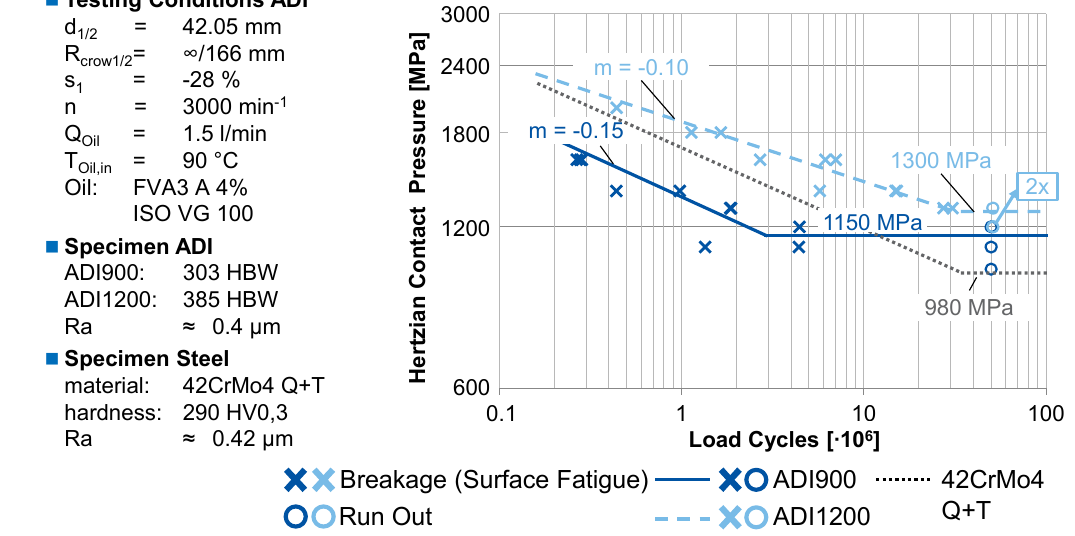
Figure 6. Comparison of the contact fatigue results for ADI900-8, ADI1200-3 and 42CrMo4.